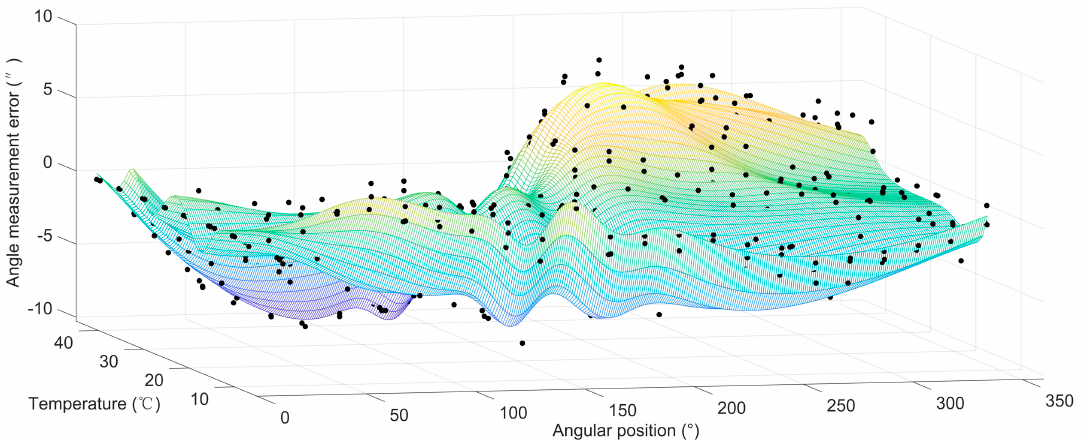
Figure 9. Compensation effect of the Fourier expansion-BP neural network optimized by genetic algorithm (FE-GABPNN) method.